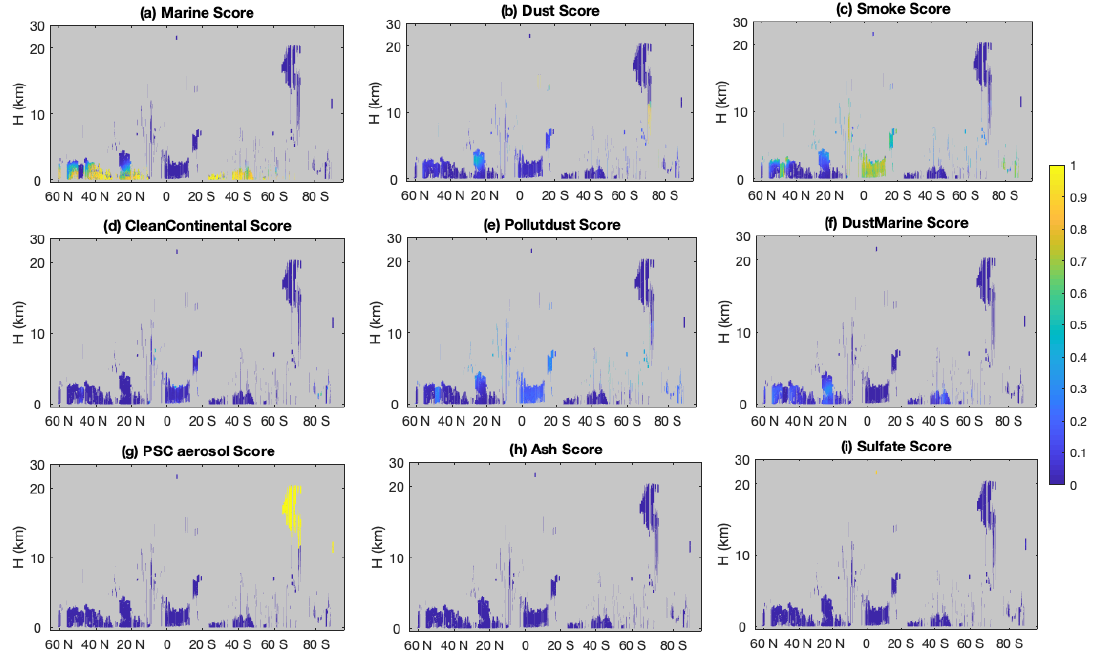
Figure 4. CNN classification scores assigned to all aerosol classes ( a ): marine aerosols; ( b ): dust; ( c ): smoke; ( d ): clean continental; ( e ): polluted dust; ( f ): dust marine aerosols; ( g ): PSC aerosols; ( h ): ash; ( i ): sulfate or other stratospheric aerosols) for nighttime data acquired on 17 August 2010, starting at 05:56:13 UTC, as shown in Figure 3. Note the smoke and elevated smoke are combined in panel ( c ).